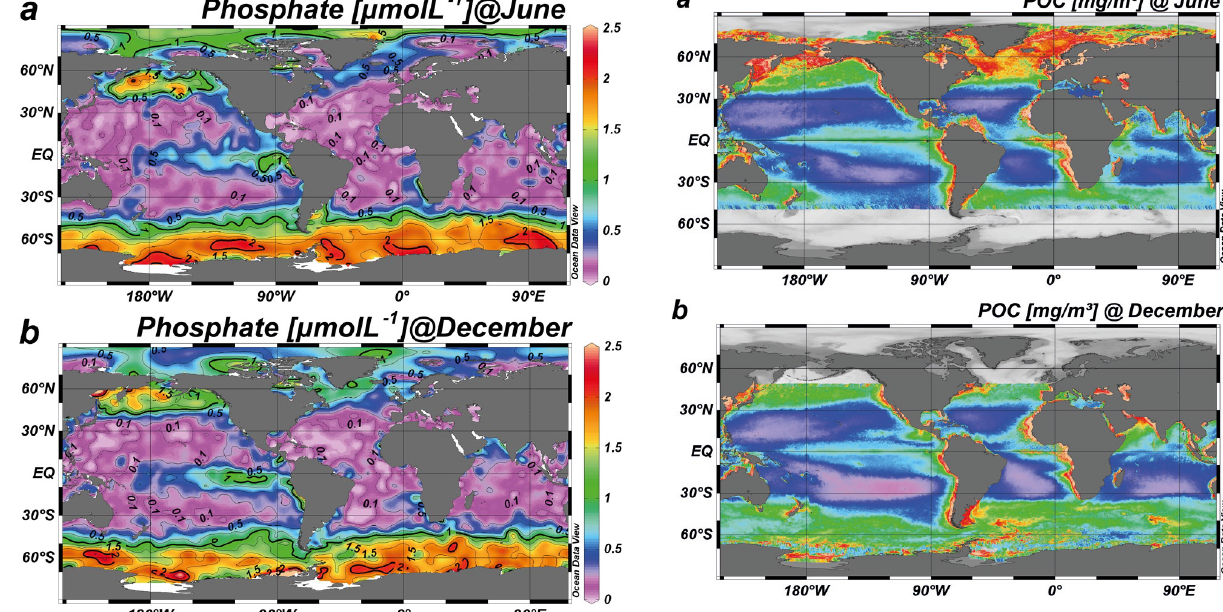
Fig. 2. Climatological surface ocean POC concentrations for June and December (Stramski et al.,